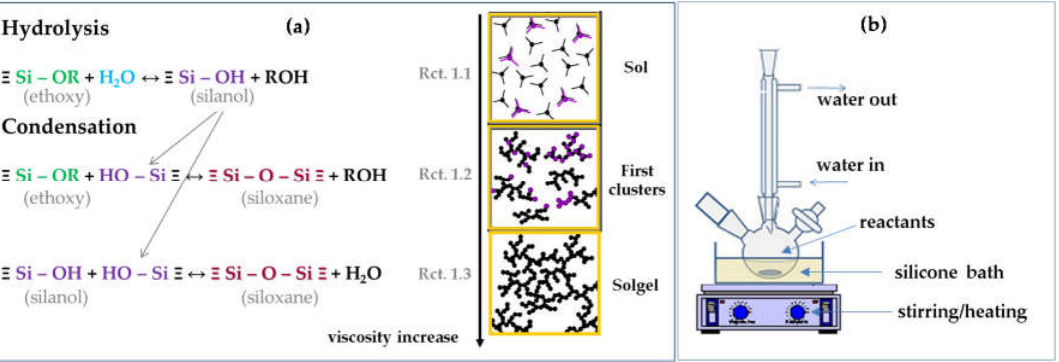
Figure 1. ( a ) Reactional mechanism of transformation of ETS40-based sol in solgel; ( b ) Experimental setup to run solgel synthesis. Rct. = reaction.